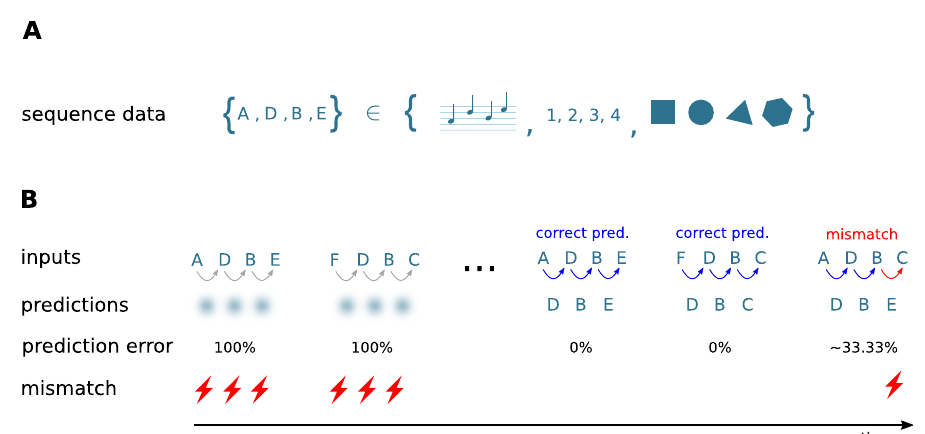
Fig 1. Sketch of the task and the learning protocol. A) The neuronal network model developed in this study learns and processes sequences of ordered discrete elements, here represented by characters “A”, “B”, “C”, ... . Sequence elements may constitute arbitrary discrete items, such as musical notes, numbers, or images. The order of sequence elements represents the temporal order of item occurrence. B) After repeated, consistent presentation of sets of high- order sequences, i.e., sequences with overlapping characters (here, {A, D, B, E} and {F, D, B, C}), the model learns to predict subsequent elements in response to the presentation of other elements (blue arrows) and to detect unanticipated elements by generating a mismatch signal if the prediction is not met (red arrows and flash symbols). The learning process is continuous and unsupervised. At the beginning of the learning process, all presented elements are unanticipated and hence trigger the generation of a mismatch signal. The learning progress is monitored and quantified by the prediction error (see Task performance measures).